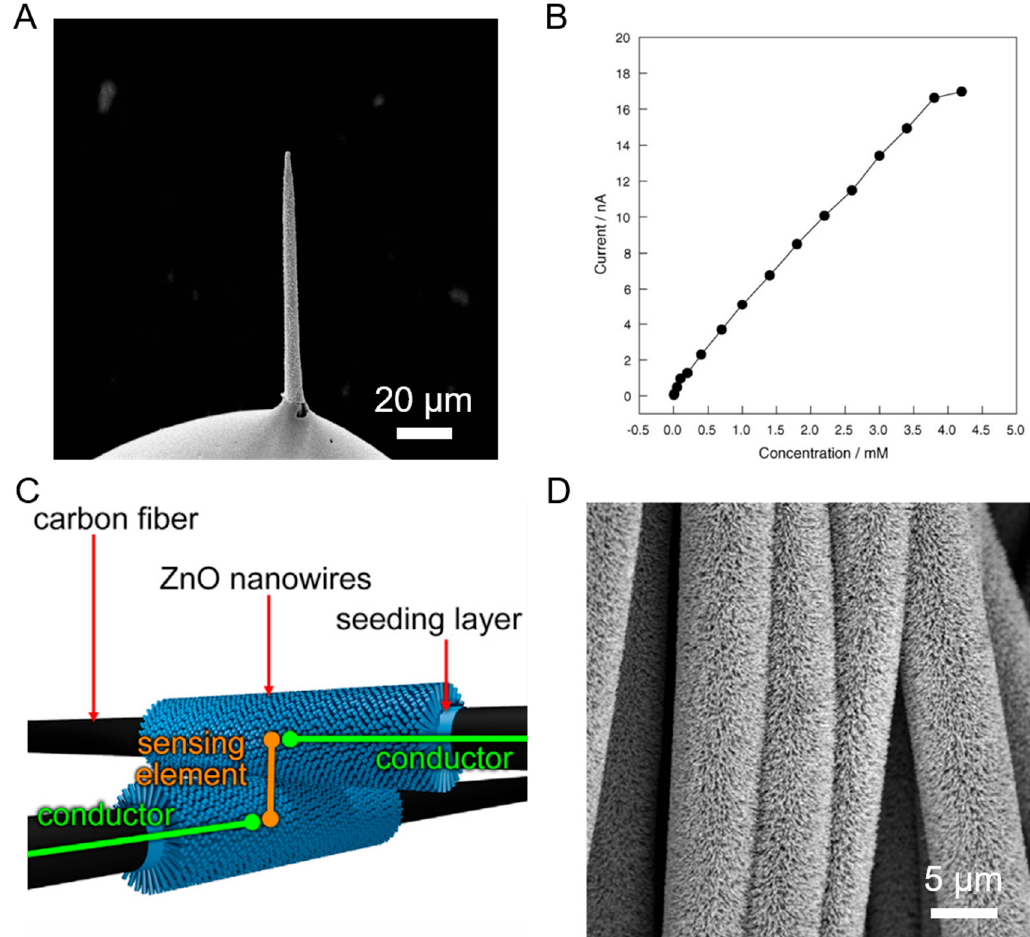
Figure 7. ( A ) SEM image of Pt NP doped carbon fiber ultramicroelectrode (Pt/CFUME). ( B ) Response curve for the H 2 O 2 sensor. Reproduced with permission from [62]. ( C ) Schematic of the two crossing CFs functionalized with ZnO nanowires (NWs). ( D ) SEM image of CF functionalized with ZnO NWs. Reproduced with permission from [68].